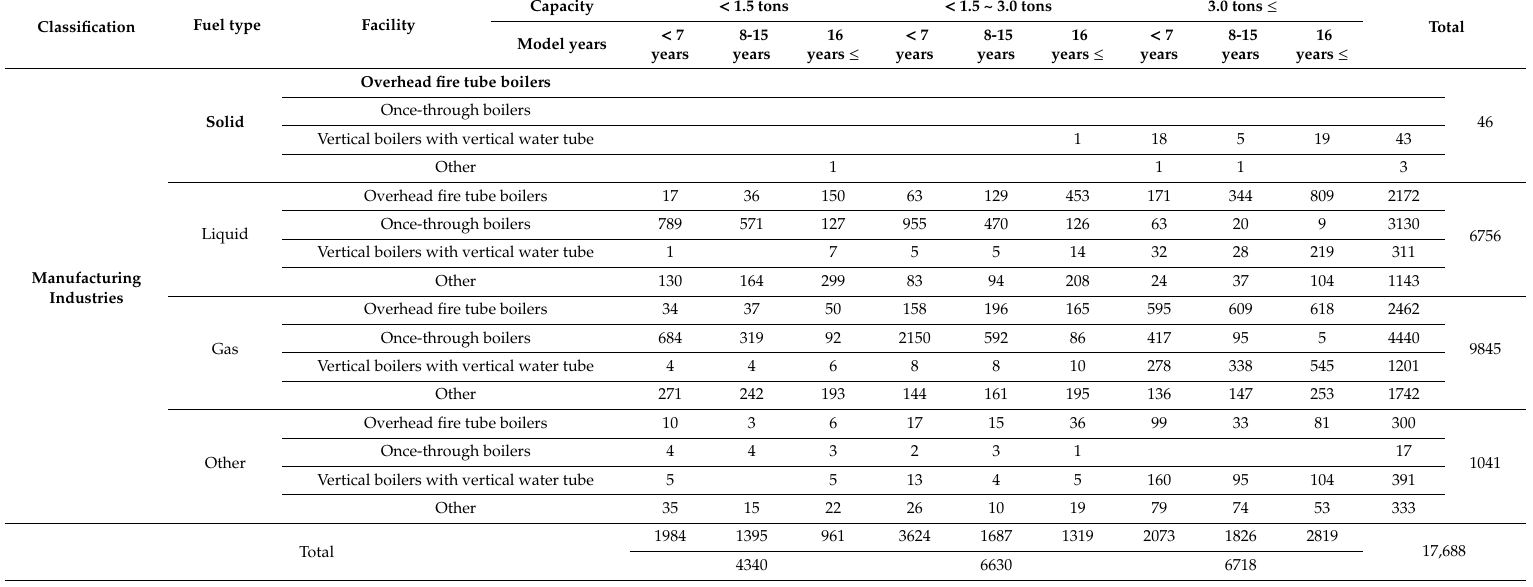
Table 1. Population of the investigated boilers in